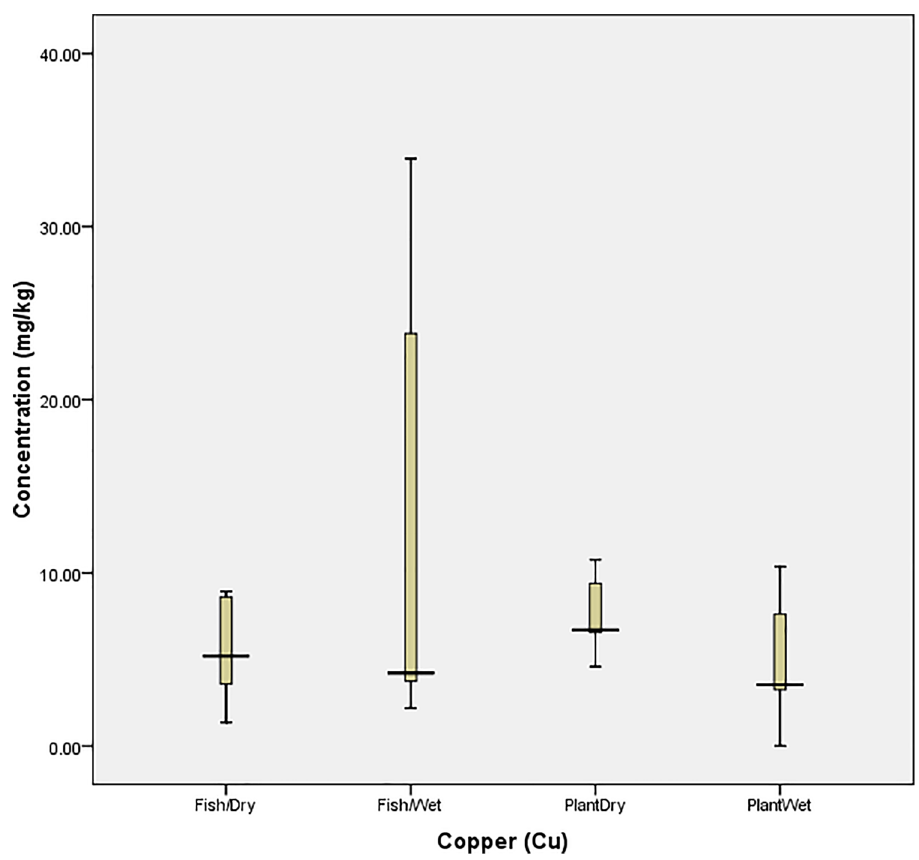
Figure 4. Tolerability of Copper (Cu) in O. niloticus (Fish) and I. aquatica (Plant) in Wet and Dry Seasons (Source: Field